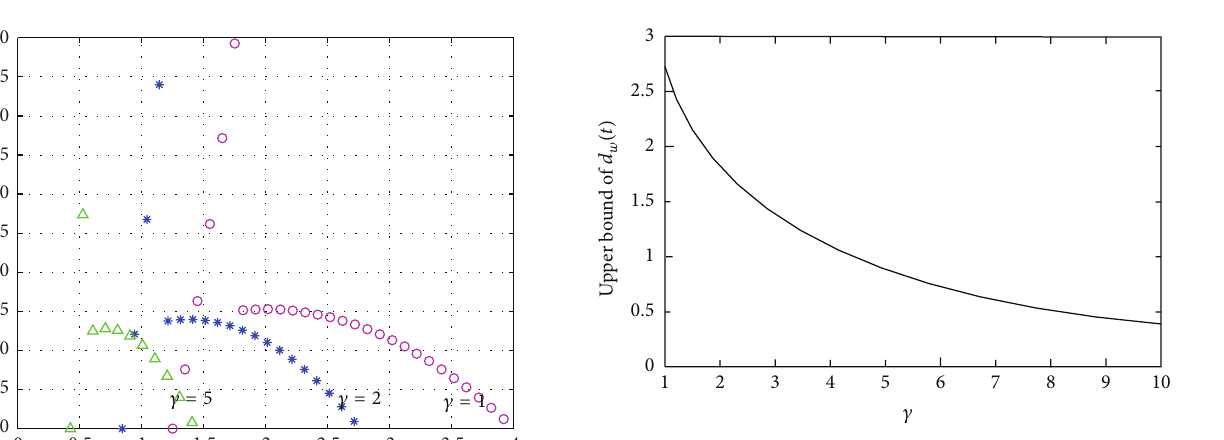
Figure 5: The bound above which an adding link cannot make the total costs increase under